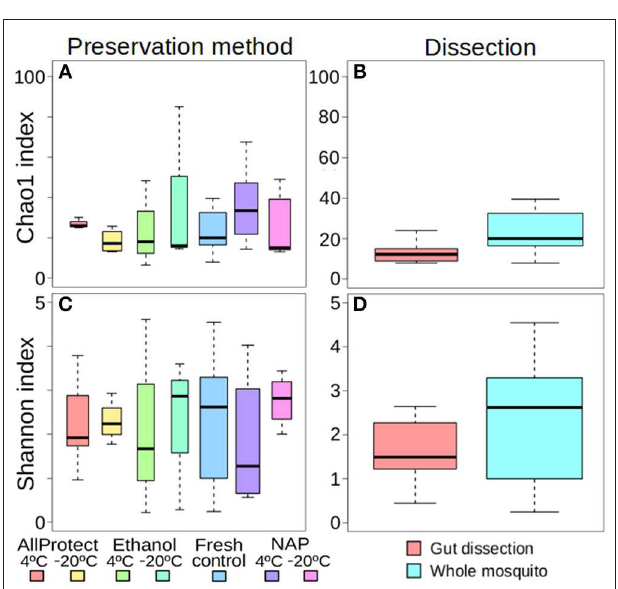
FIGURE 2 | Box-plots showing the alpha-diversity of Aedes vexans microbiomes with the different processing treatments of this study: Chao1 index according to (A) preservation method and (B) dissection; Shannon index according to (C) preservation method and (D)